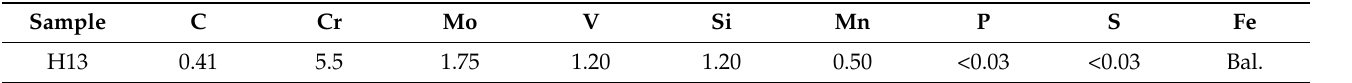
Table 1. The chemical composition of H13 tool and die